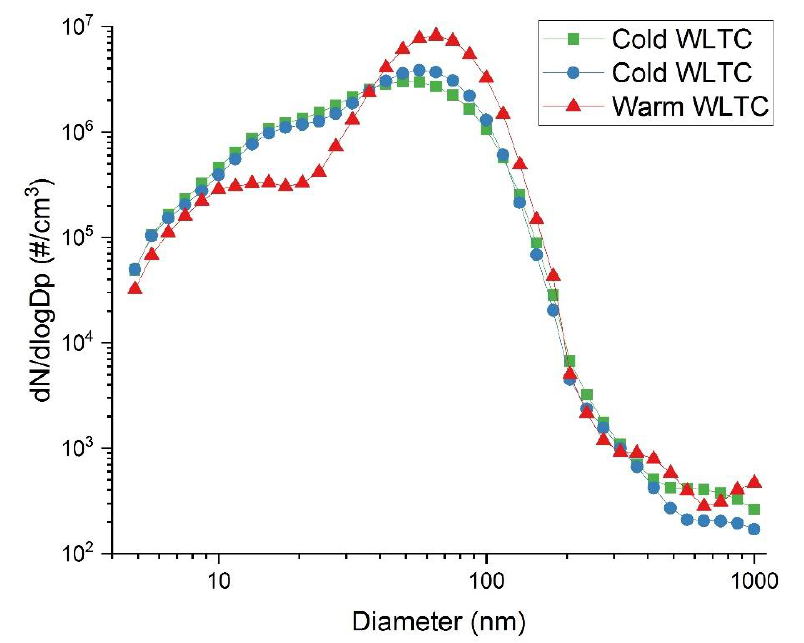
Figure 17. Comparison of the average PNSD over the first 300 s of cold and warm start WLTCs.